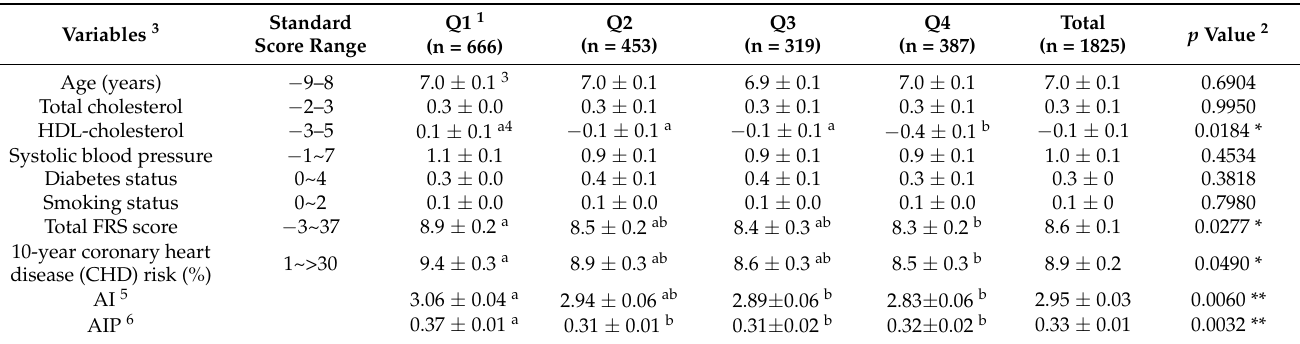
Table 5. Framingham Risk Score (FRS) according to cow’s milk intake frequency.